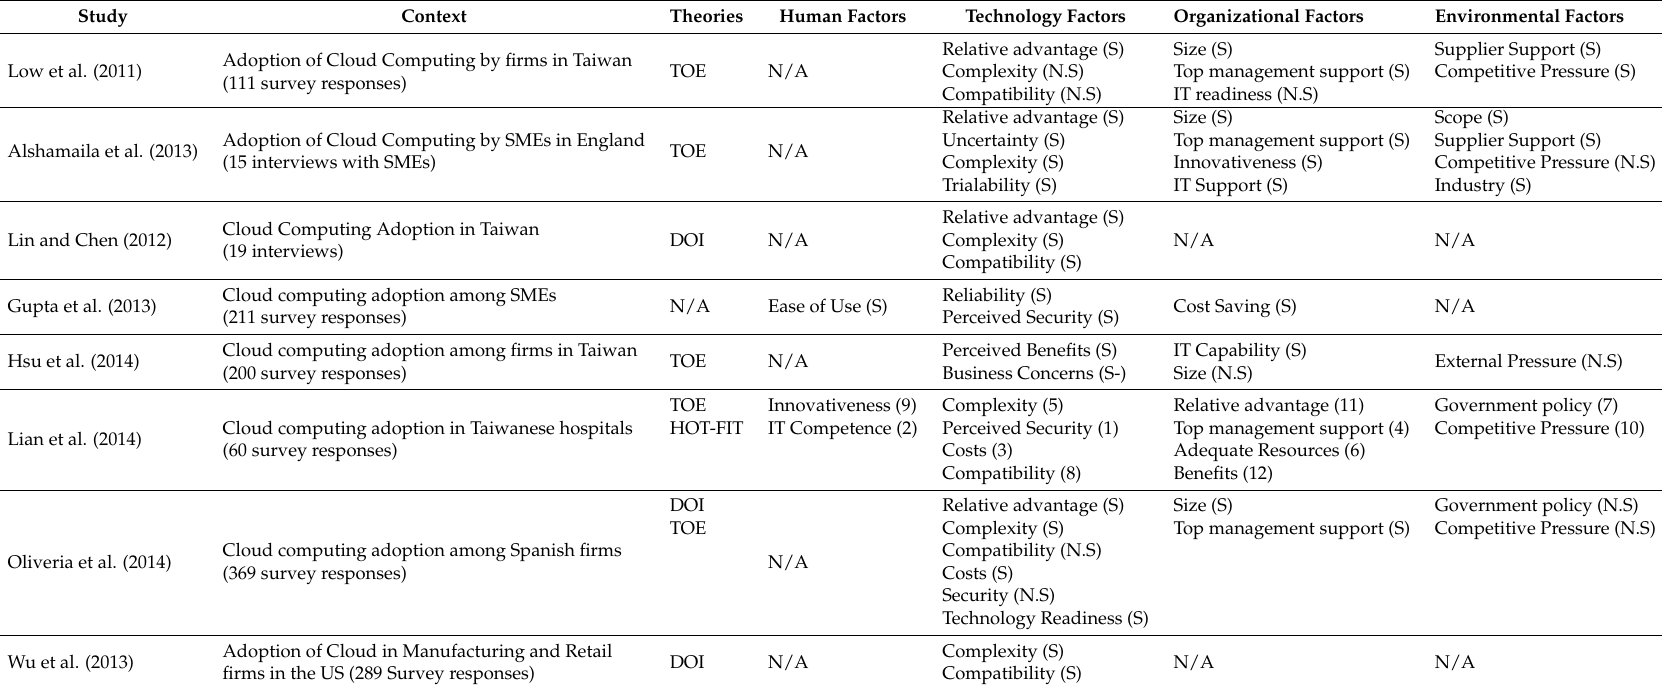
Table 2. Cloud computing adoption